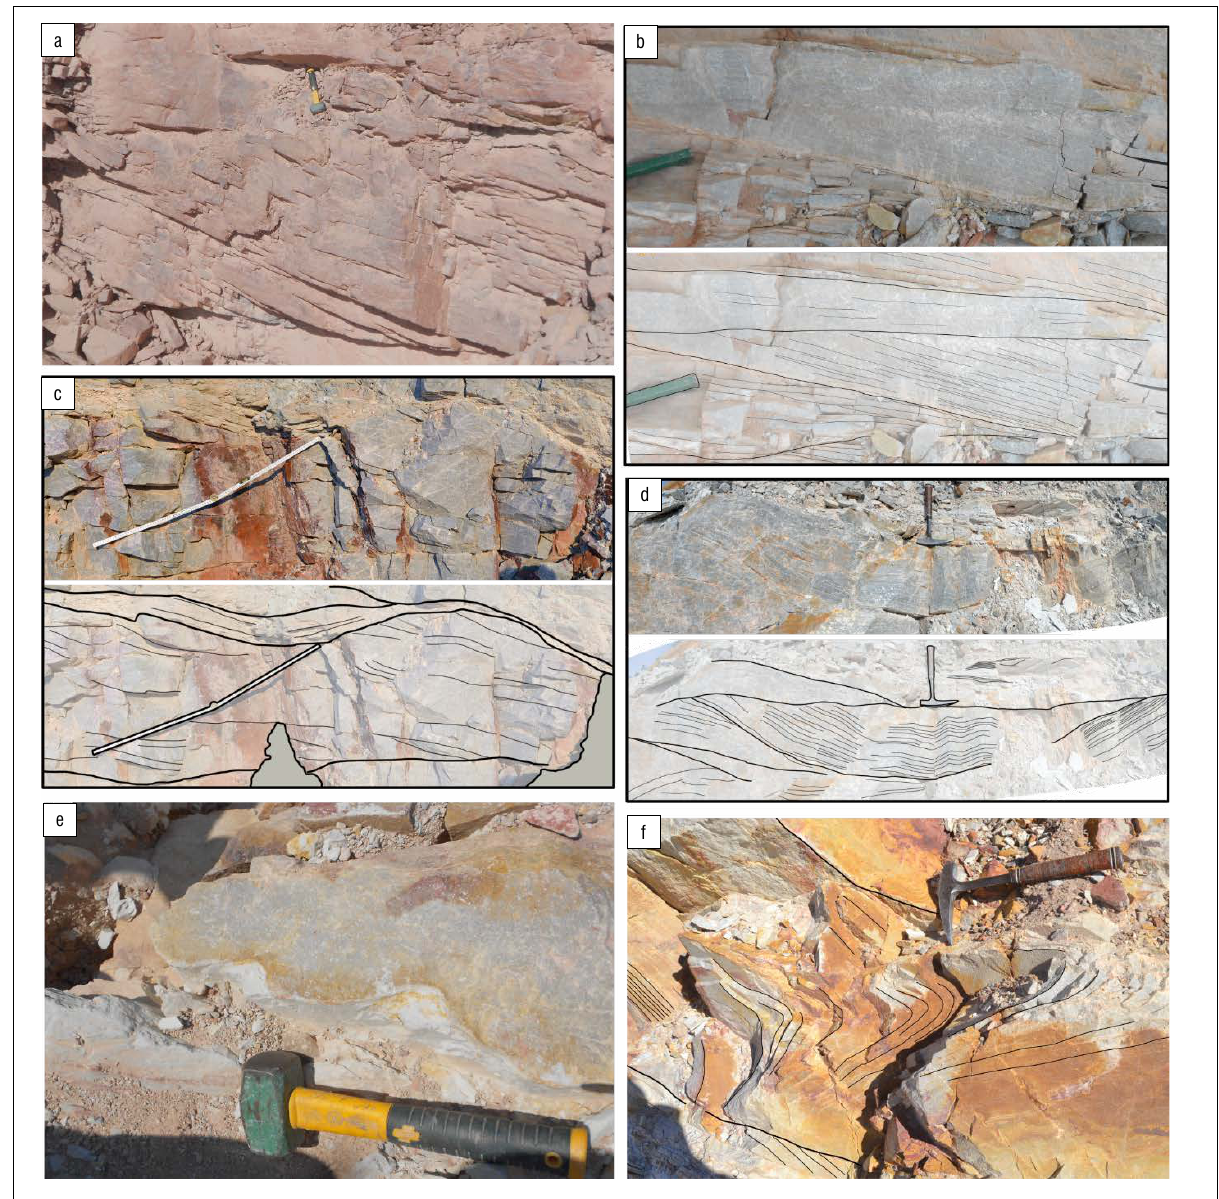
Figure 4: Sedimentary facies at Coombs Hill. (a) Thickly bedded planar cross-stratification (4-lb hammer for scale). (b) Low-angle planar cross-stratification (handle of chisel is approximately 2 cm wide). (c) Swaley cross-stratification (scale is 1 m). (d) Channelised trough cross-stratification (geological pick for scale). (e) Stepped channel bank eroded into mudstone (4-lb hammer for scale). (f) Parabolic cross-stratification (younging direction towards the bottom of the photograph, geological pick for scale). (b,c,d,f,) Interpretive line drawings showing erosive set bounding surfaces (thicker lines) and bedding planes (thinner